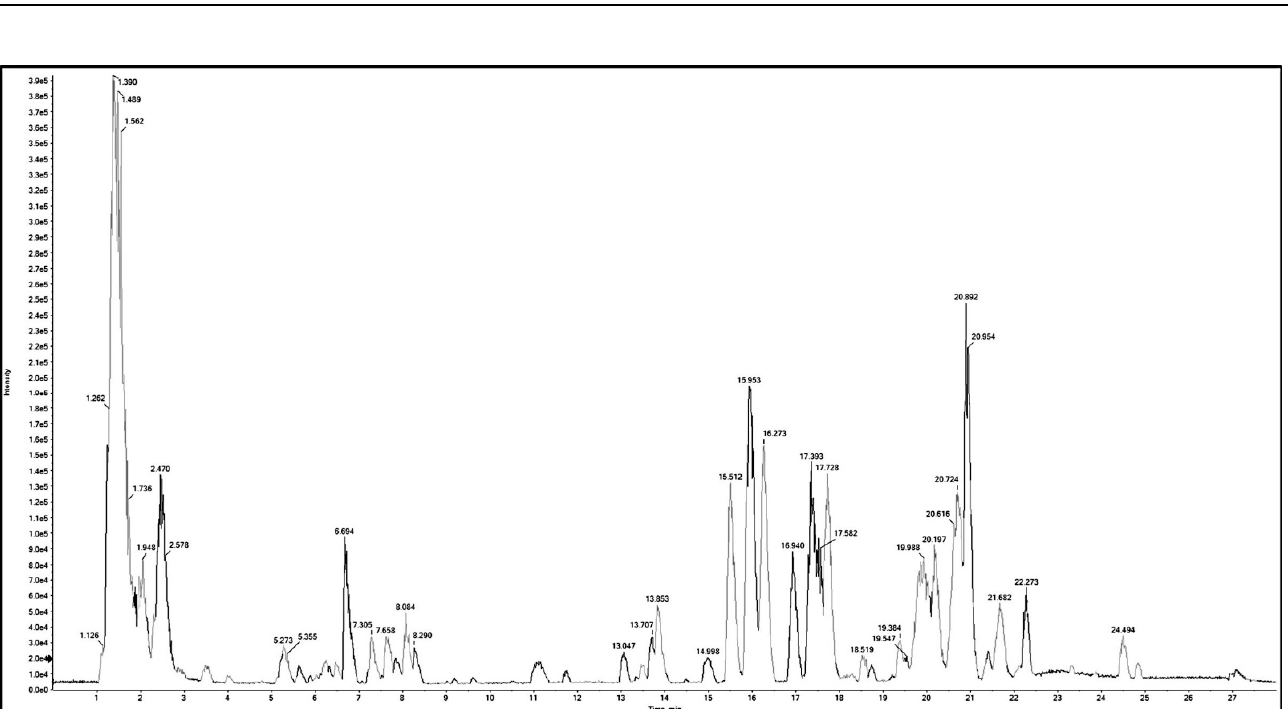
Figure 1. Base peak chromatogram (BPC) of Q-TOF LC/MS/MS analysis of B. armeniaca methanolic extract (BME) in positive mode.